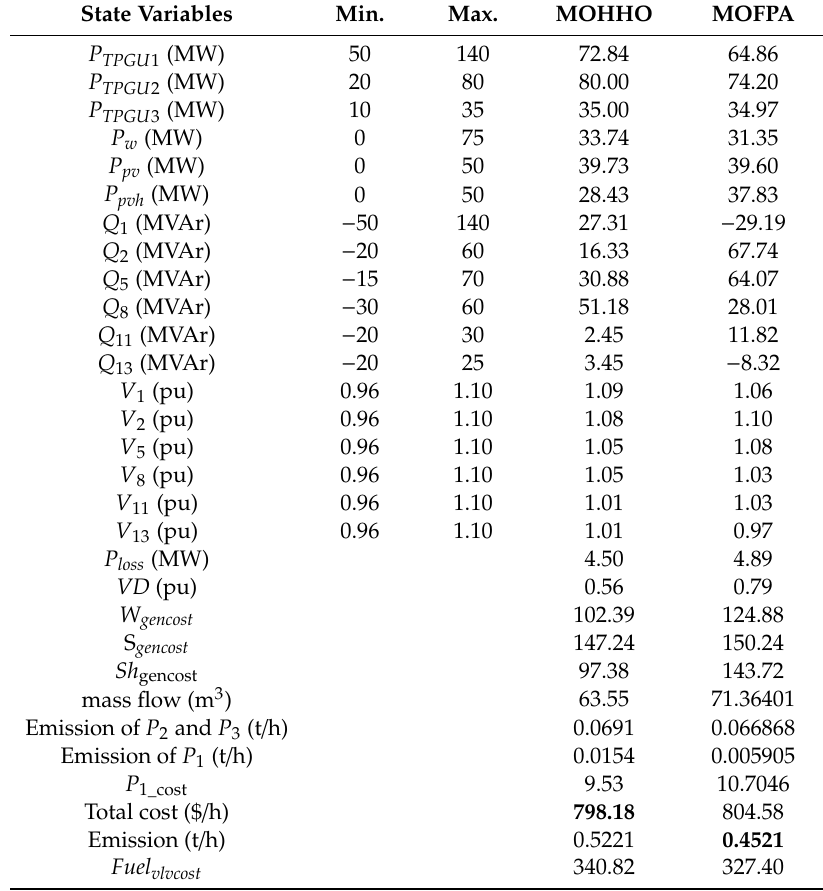
Table 7. Detailed numerical results of the optimization techniques for Scenario